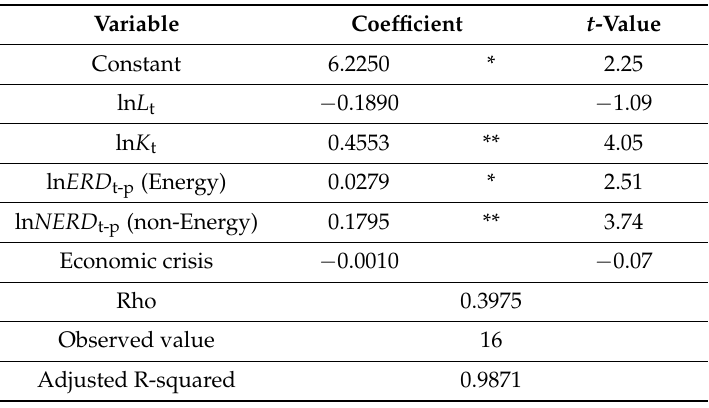
Table 2. Estimation results of the Cochrane-Orcutt iterative